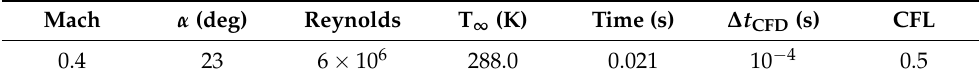
Table 3. Delta wing simulation